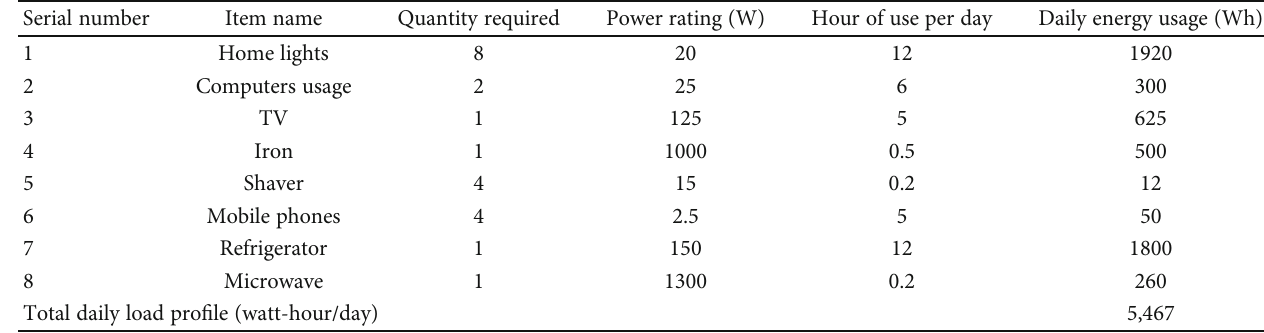
Table 1: Electrical consumption of equipment and daily energy usage for a home in Kigali city.